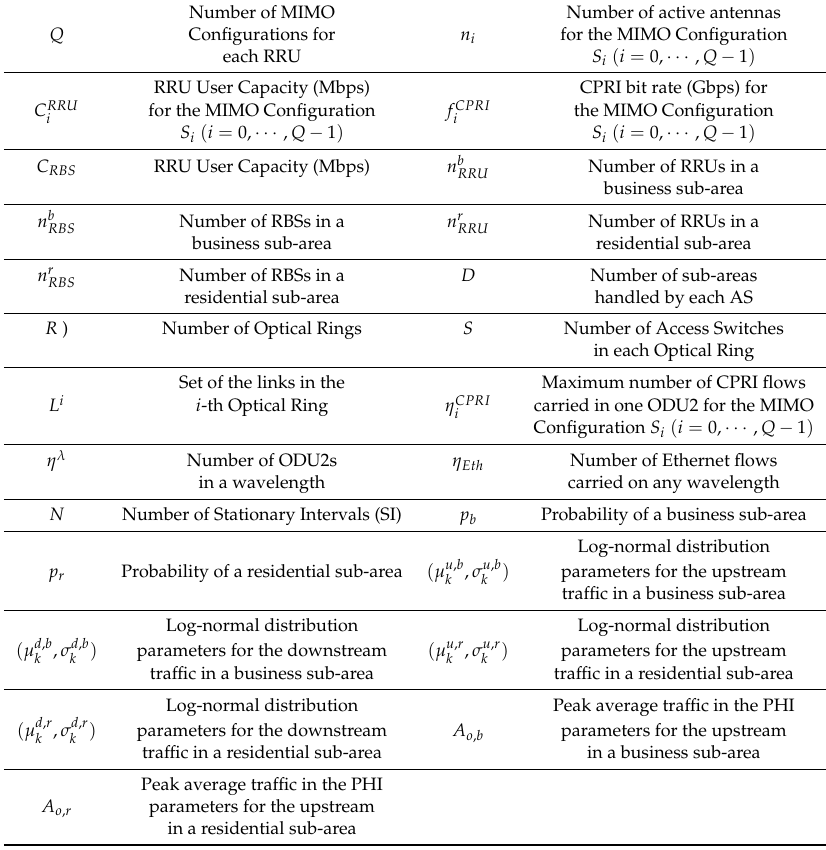
Table 1. Radio station, OTN/WDM network and traffic